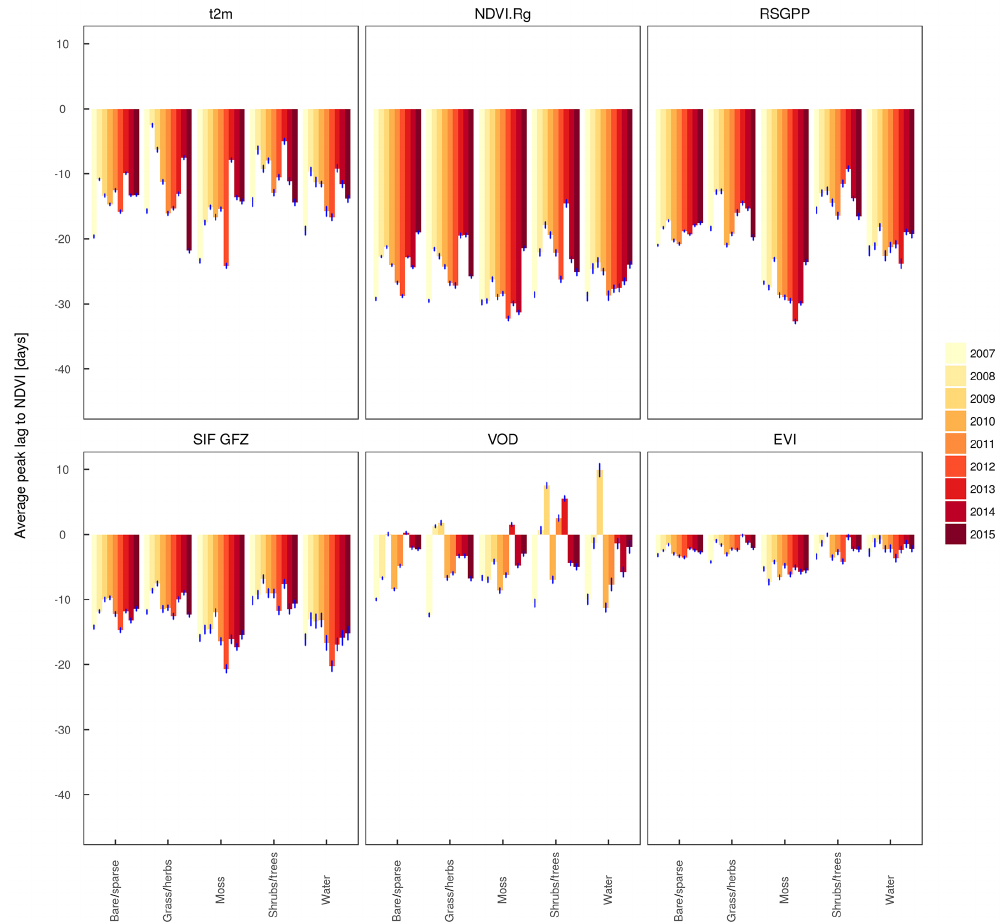
Figure 8. Average of the time difference between the peaks of one selected variable per family (APAR, fAPAR, SIF, GPP, VOD) and the NDVI as a reference, weighted with fractional cover per vegetation type (based on ESA CCI) and per year. Each bar represents the average of 50 bootstrap samples of the time series per year, pixel and vegetation proxy; error bars indicate a multiple of 1.96 of the standard deviation across the 50